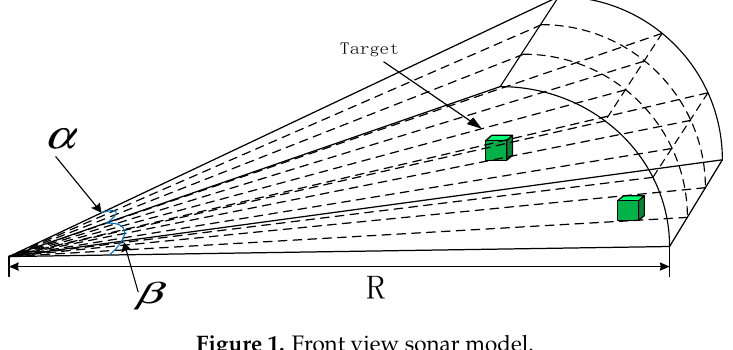
Figure 1. Front view sonar model.